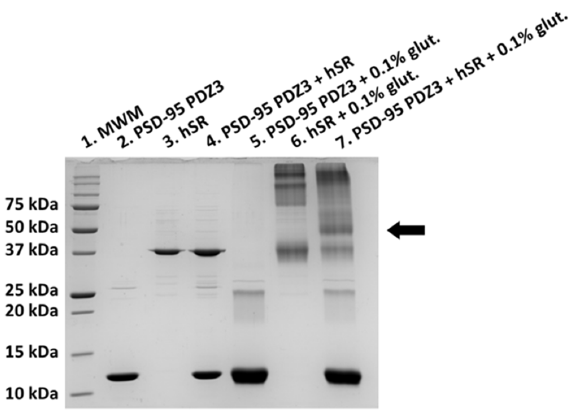
Figure 3 . SDS ‐ PAGE after cross ‐ linking with 0.1% glutaraldehyde of hSR and PSD ‐ 95 PDZ3.